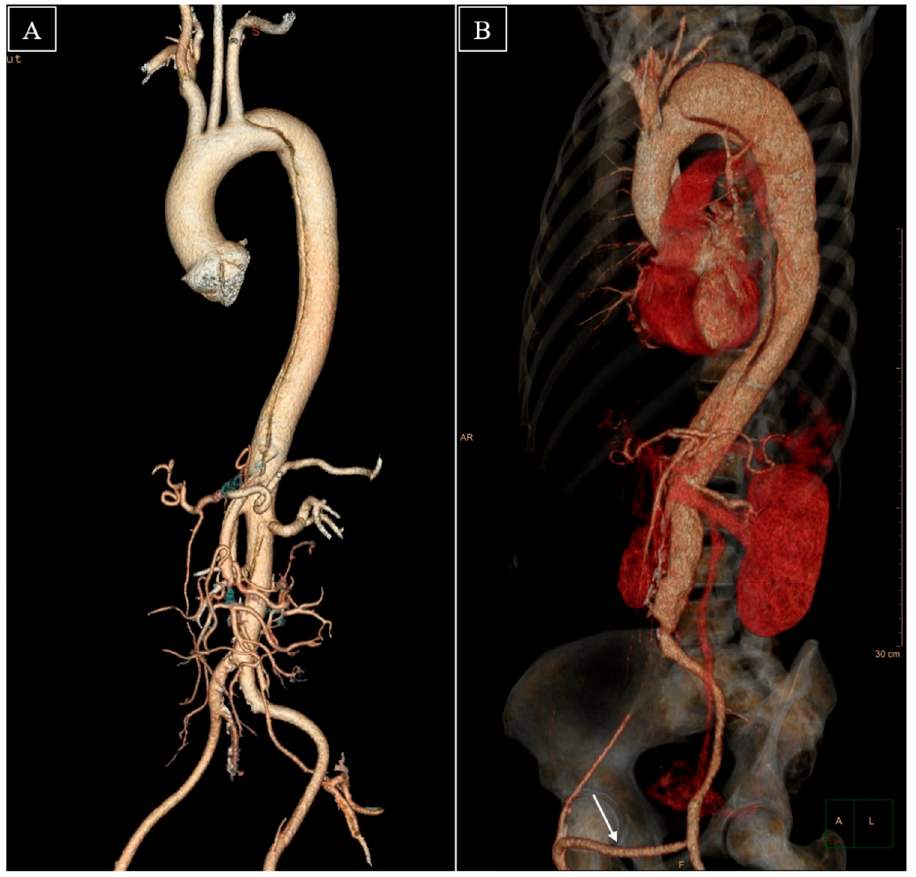
Figure 1. 3D computed tomography angiography. ( A ) The TBAD in 2013. ( B ) The TBAD in 2020. The white arrow indicates the femoro–femoral crossover bypass graft implanted in 2013.